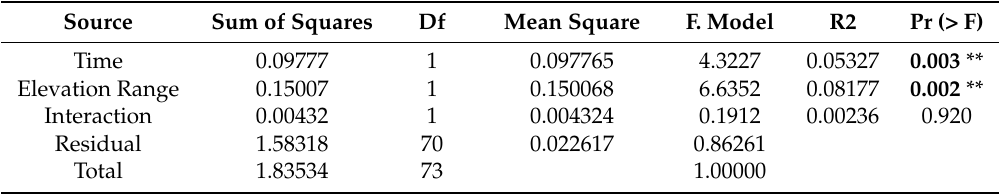
Table 2. Results of permutational multivariate analysis of variance (PERMANOVA). Effect of the time period (T1: 1992 and T2: 2016–2017) and the vegetation belt (lower subalpine and upper subalpine) on species abundance, mean Ellenberg indicator values, and life forms. Asterisks indicate significant